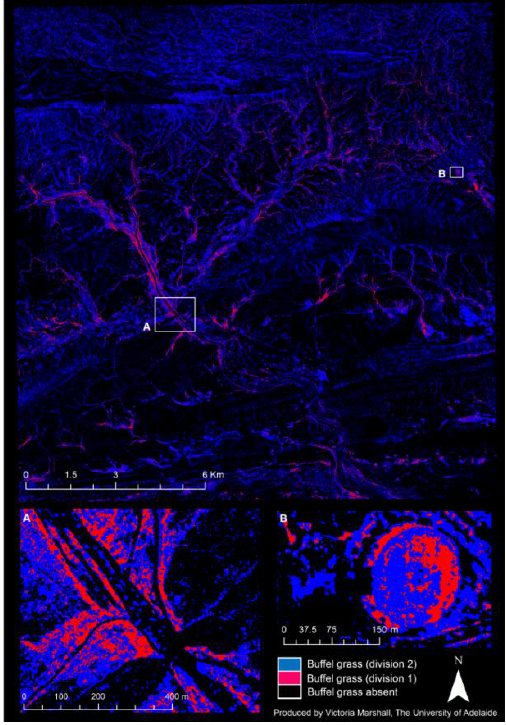
Figure 5: Worldview-2 image classified using MTMF target detection and reduced, based on band thresholds, to three classes Buffel grass absence (black), presence (division 1) (red) and presence (division 2) (blue) where division 1 is mostly likely to be Buffel